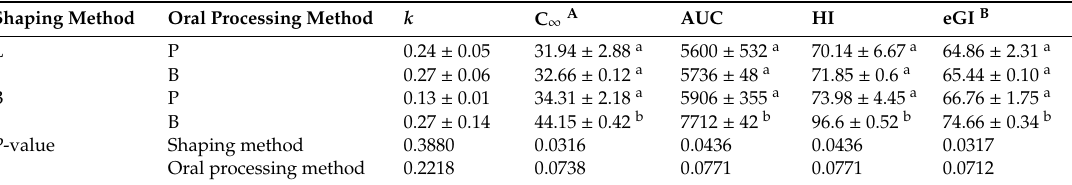
Table 2. Kinetic constant ( k ), equilibrium concentration ( C ∞ ), area under the hydrolysis curve after 180 min (AUC), hydrolysis index (HI) and estimated glycemic index ( eGI ) for loaf bread (L) and bread rolls (B) subjected to two di ff erent simulating oral processing methods, with Ultra Turrax (P) or crystal balls (B).